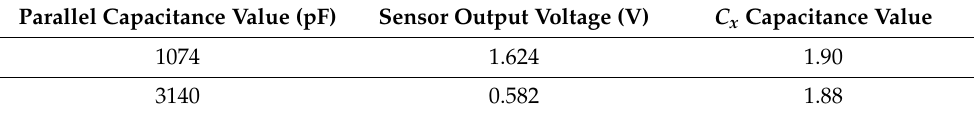
Figure 18. Varying the value of sampling capacitance, the sensor outputs di ff erent voltages. ( a ) Sam- pling capacitance value is 1074 pF; ( b ) Sampling capacitance value is 3140 pF. Table 3. The output of the sensor after paralleling di ff erent capacitors and the calculated 𝐶 (cid:3051) value. Parallel Capacitance Value ( pF ) Sensor Output Voltage ( V )